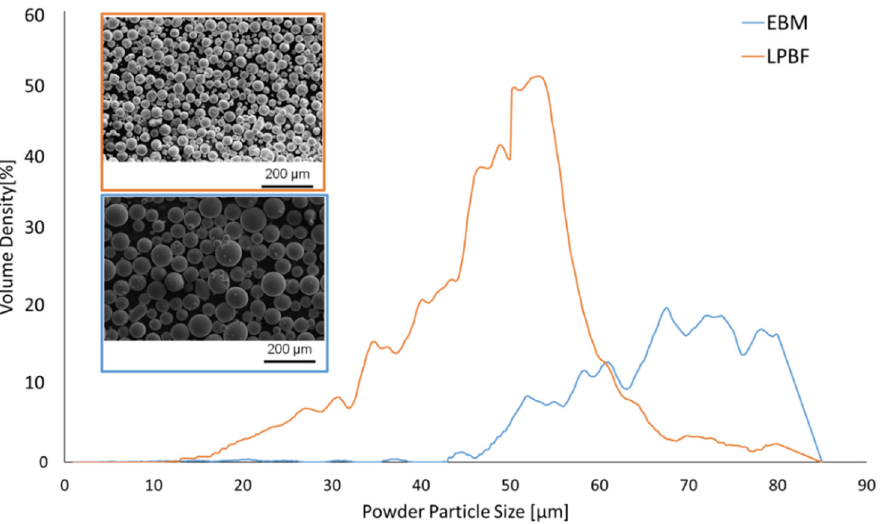
Figure 1. Powder particle size distribution and scanning electron microscope (SEM) images for LPBF and EBM powder.